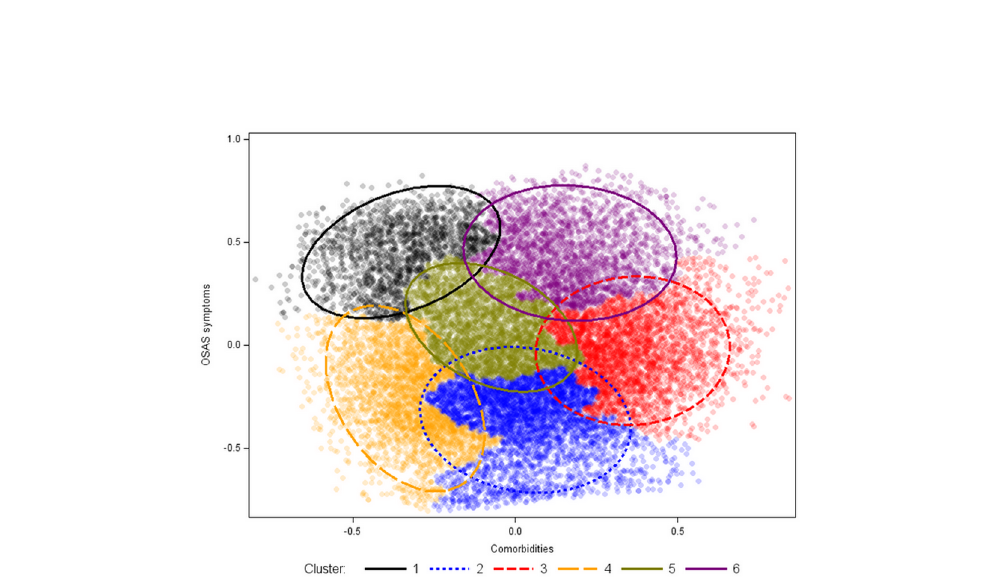
Fig 1. Representation of six clusters after ascending hierarchical clustering analysis. Axes correspond to individual coordinates for the two main dimensions of the multiple correspondence analysis. Cluster 1: the young symptomatic. Cluster 2: the old obese. Cluster 3: the multi-disease (MD) old obese. Cluster 4: the young snorers. Cluster 5: the drowsy obese. Cluster 6: the MD obese symptomatic.